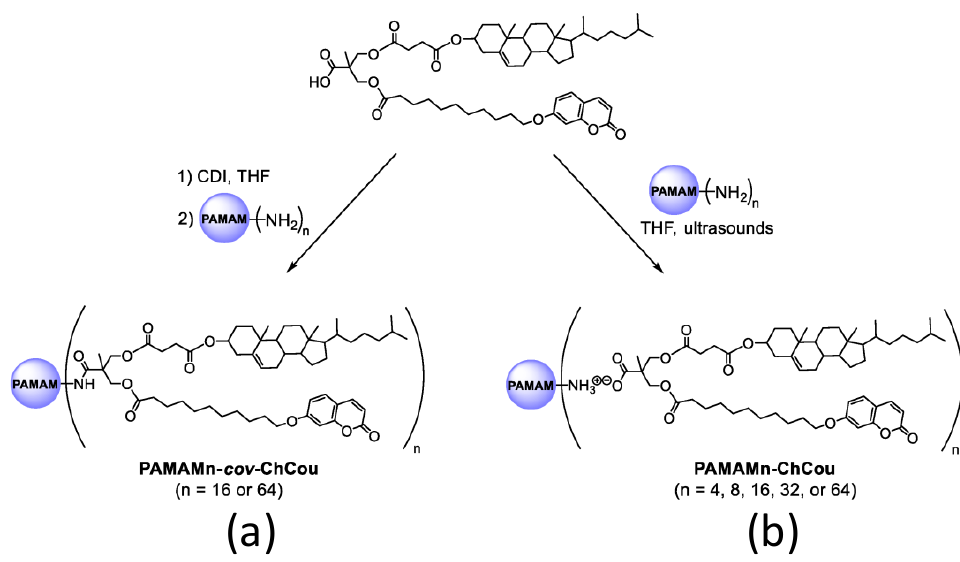
Figure 7. Covalent ( a ) and ionic ( b ) functionalization of PAMAM dendrimer with a hybrid bisMPA dendron bearing cholesterol and coumarin moieties. Reproduced from reference [79]. Licensed under CC-BY 4.0.